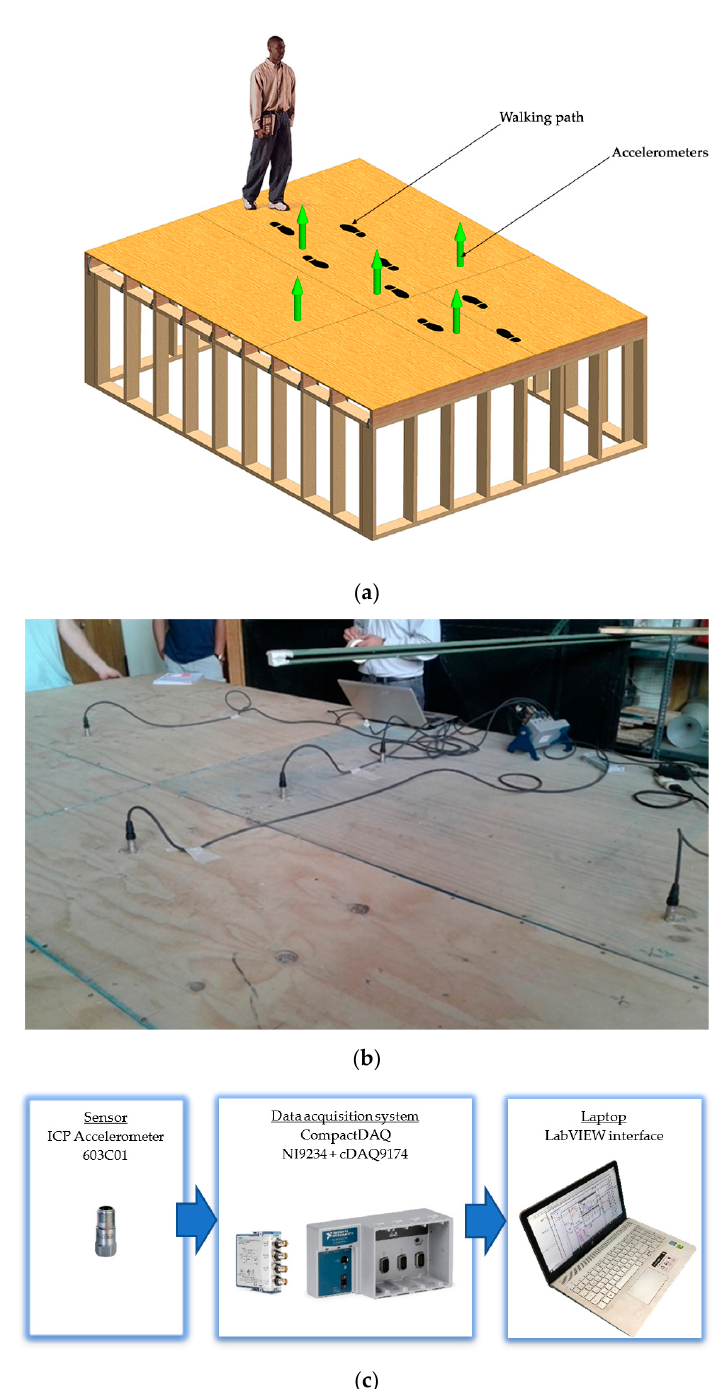
Figure 4. ( a ) Walking paths and accelerometer locations, ( b ) test setup on laboratory timber floors, and ( c ) instrumentation diagram.